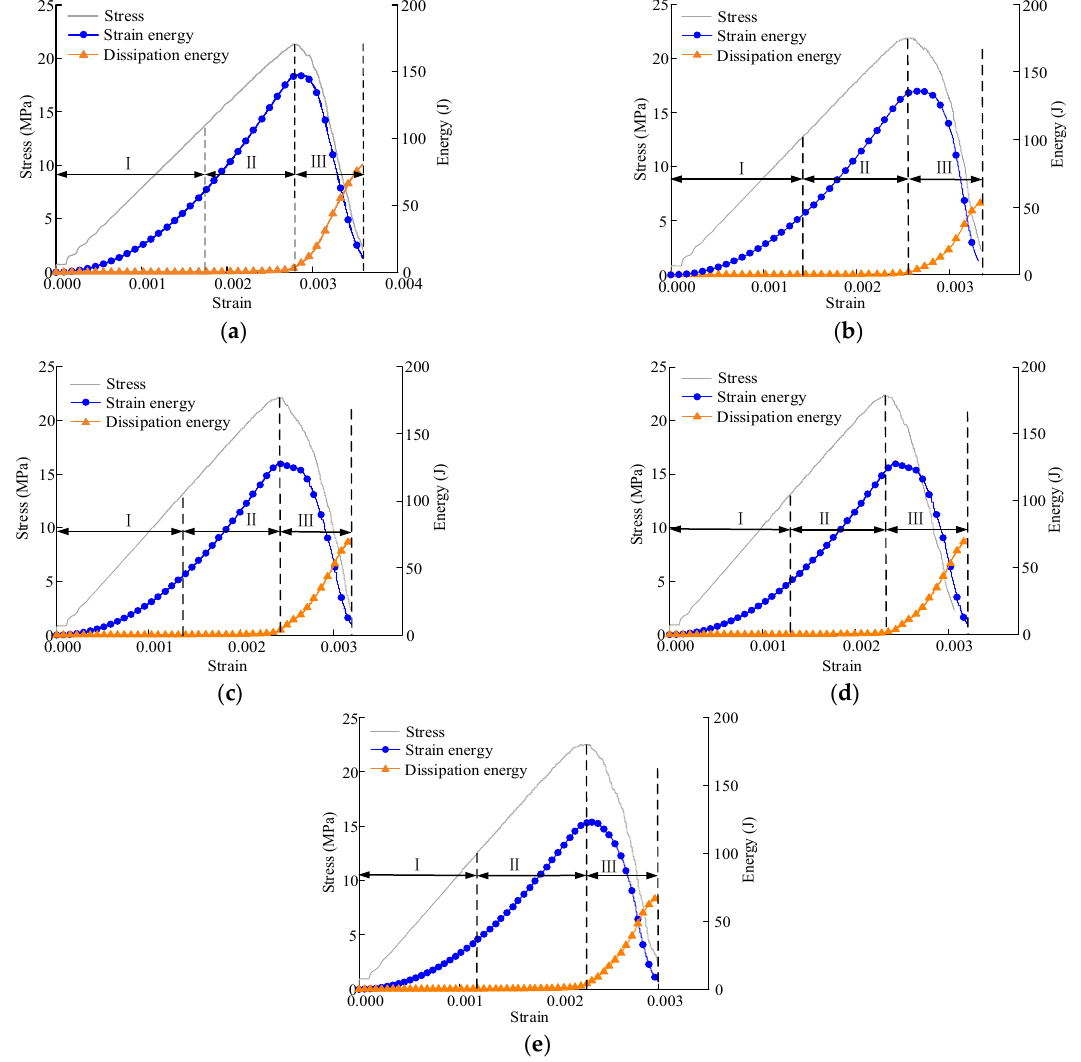
Figure 6. Energy evolution law of coal–rock combinations. ( a ) Combination 1-1. ( b ) Combination 1-2. ( c ) Combination 1-3. ( d ) Combination 1-4. ( e ) Combination 1-5.